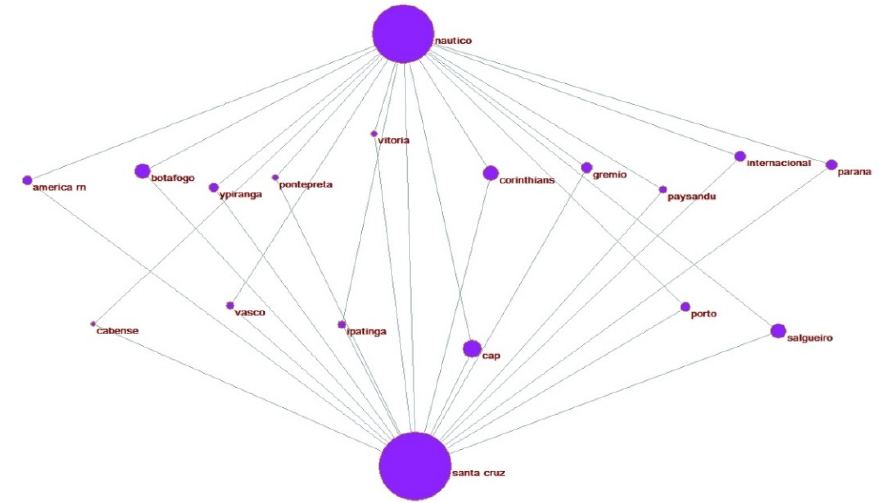
Figure 4. Coup affinity between Náutico and Santa Cruz.